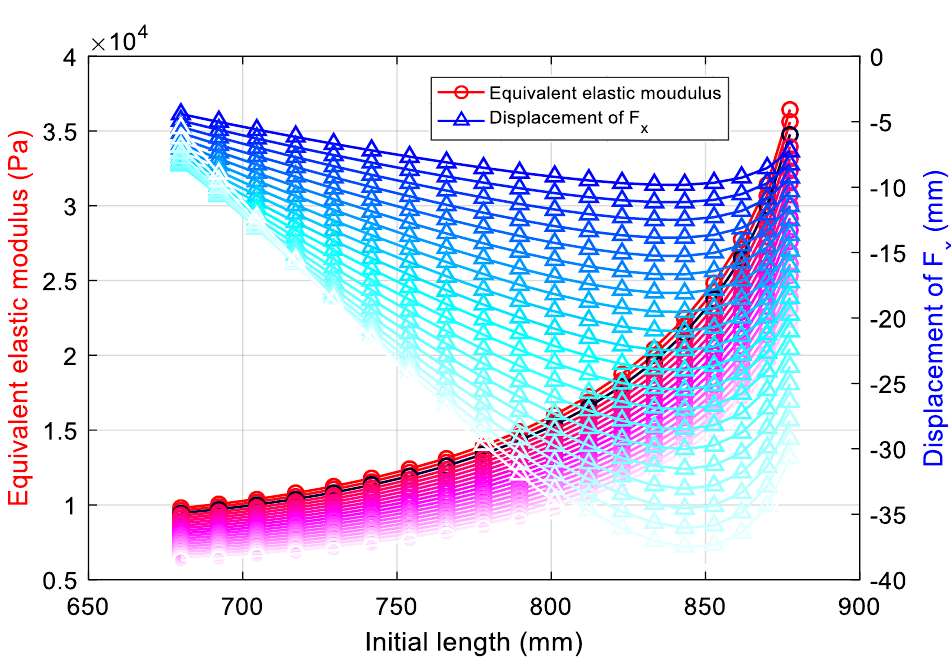
Figure 7. Effect of different initial lengths on the equivalent elastic moduli and the lateral displace- ment of the bionic leg.